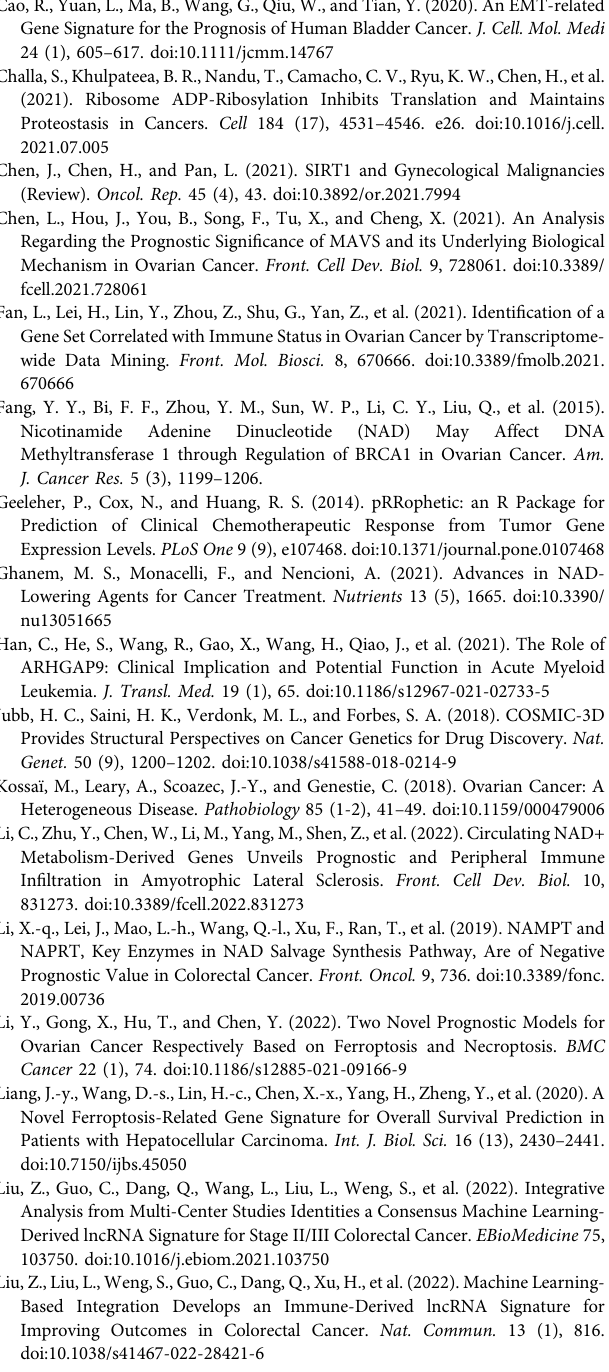
Supplementary Table S2 | Clinical information in patients with GSE26193.